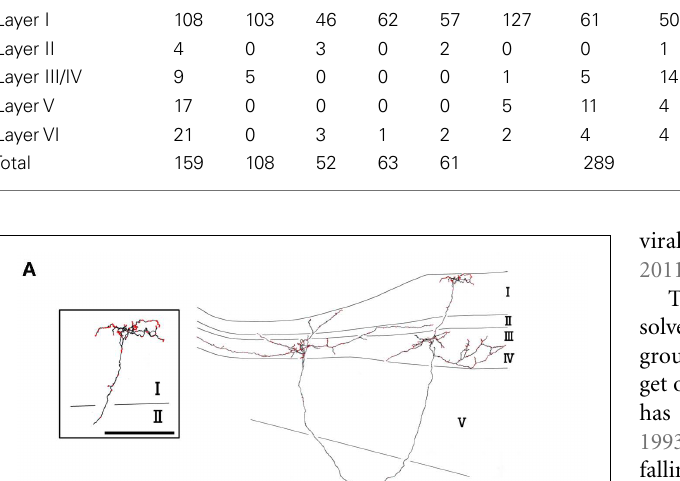
Table 2 | Number of boutons on reconstructed branches in each layer. Type of branch Branch No. Sub-branch No.